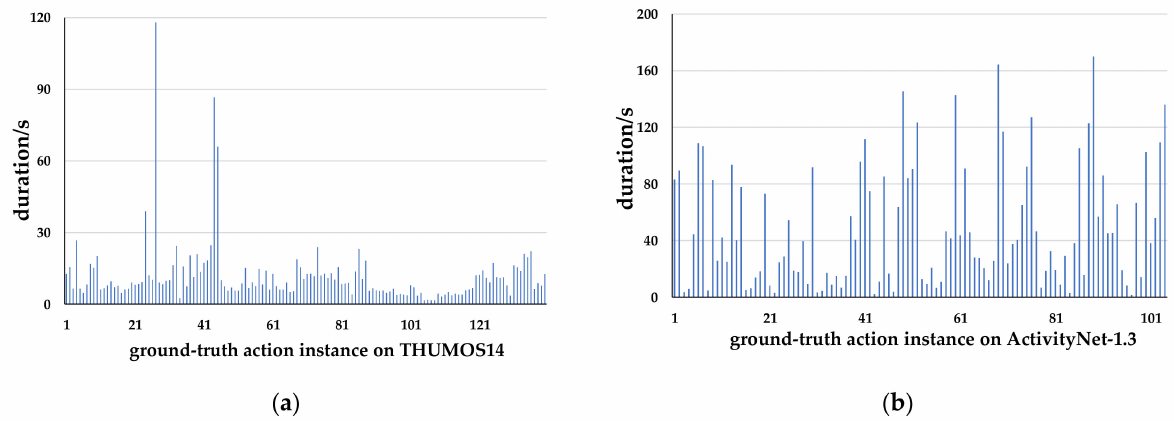
Figure 1. Diversity of a ground-truth action instance’s durations on THUMOS14 and ActivityNet-1.3 benchmarks: ( a ) ground-truth action instance’s durations on THUMOS14; ( b ) ground-truth action instance’s durations on